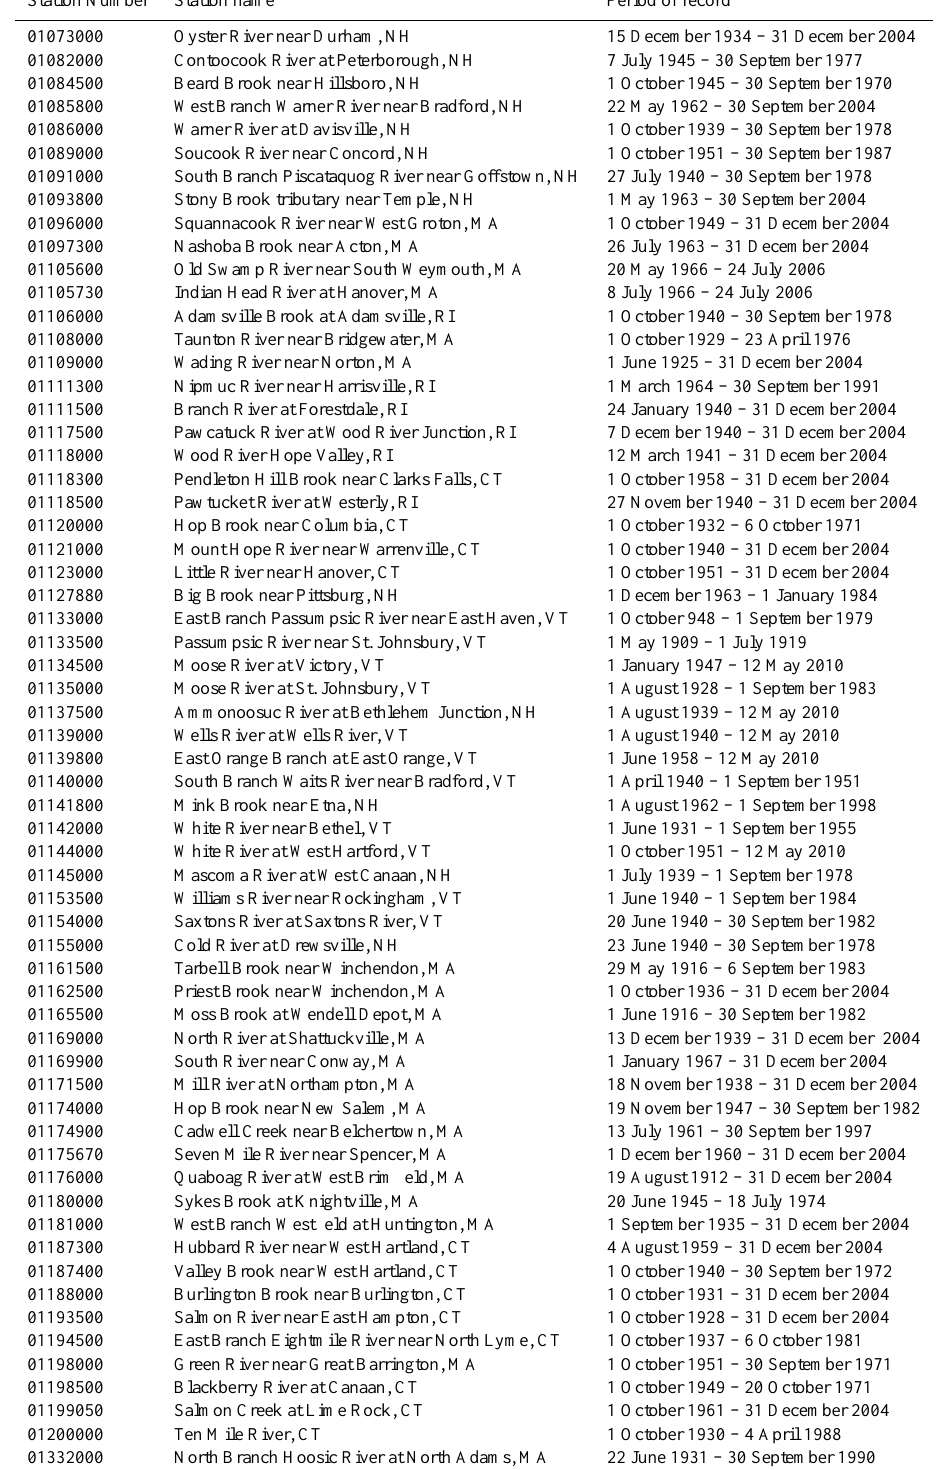
Table 1. List of streamgauges used to estimate unregulated, daily streamflow at ungauged locations in the Connecticut River